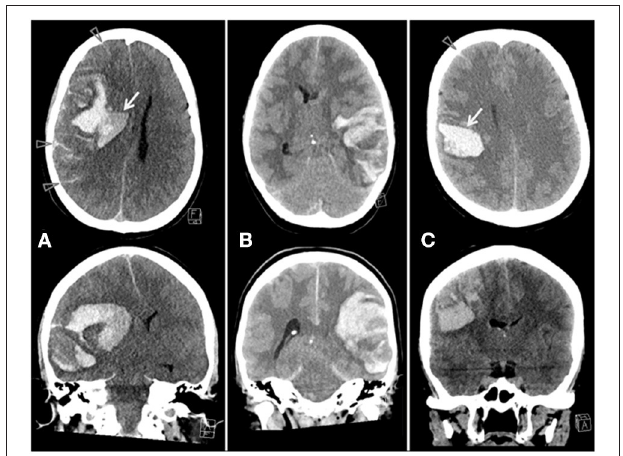
FIGURE 2 | MRI of patient 4 (upper row) and patient 2 (lower row), axial T2-weighted images (A,D) , axial T1-weighted images (B,E) and contrast-enhanced axial T1-weighted images (C,F) . A complex signal in hematomas of venous infarctions in the right cerebellar hemisphere (patient 4) and left temporal lobe (patient 2) is seen. Multiple fluid-fluid levels (arrows) and sedimentation indicate not fully coagulated blood. Multifocal areas of high signal intensity within the hematoma represents extravasated contrast agent [arrow heads, (F) ]. An acute thrombus in the right transverse and sigmoid sinus [open arrow, (C) ] cause a well-defined filling defect on the contrast-enhanced T1-MPRAGE. The round lesion with low signal intensity on T2-weighted image [thick arrow, (D) ] was tubular on consecutive slices, showed lack of contrast enhancement and is compatible with a cortical vein